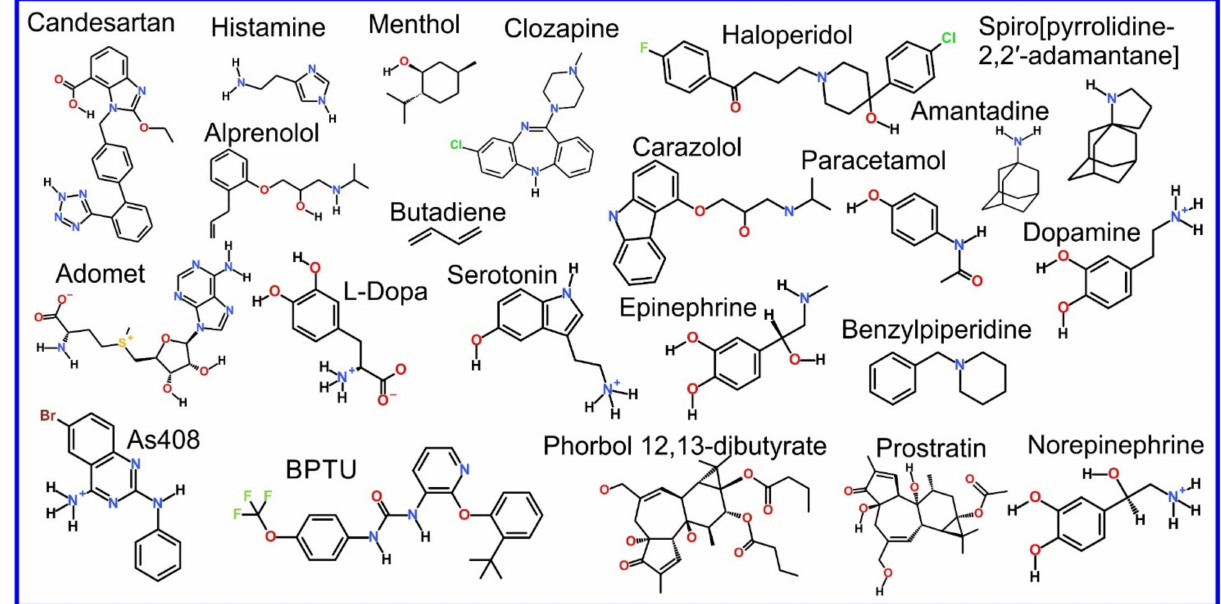
Figure 17. Chemical structure of drugs introduced in Section